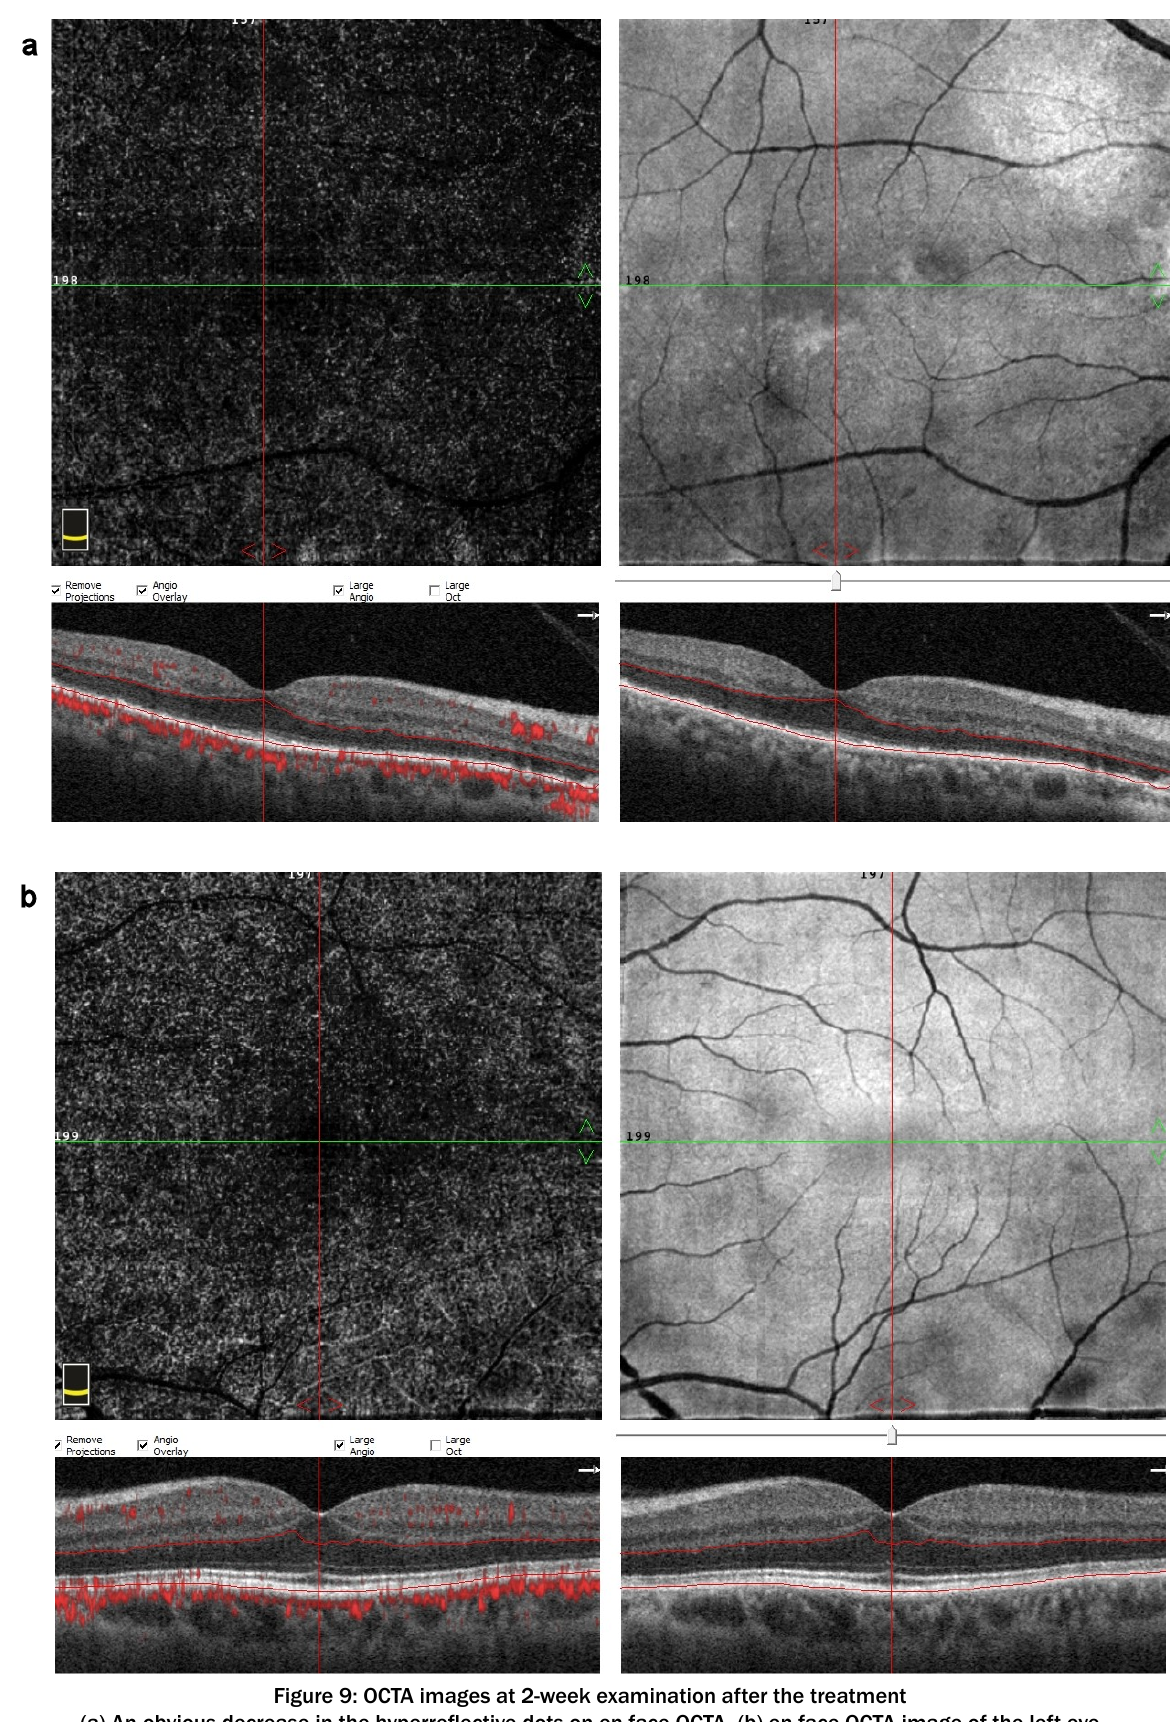
Figure 9: OCTA images at 2-week examination after the treatment (a) An obvious decrease in the hyperreflective dots on en-face OCTA, (b) en-face OCTA image of the left eye